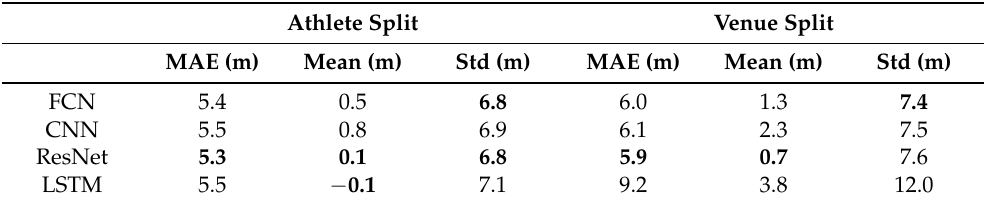
Table 3. Mean absolute error, mean, and standard deviation of the residual of different deep learning architectures. The prediction of an FCN, CNN, ResNet, and LSTM is tested for nested cross-validation split by athletes and venues. Athlete Split Venue Split MAE